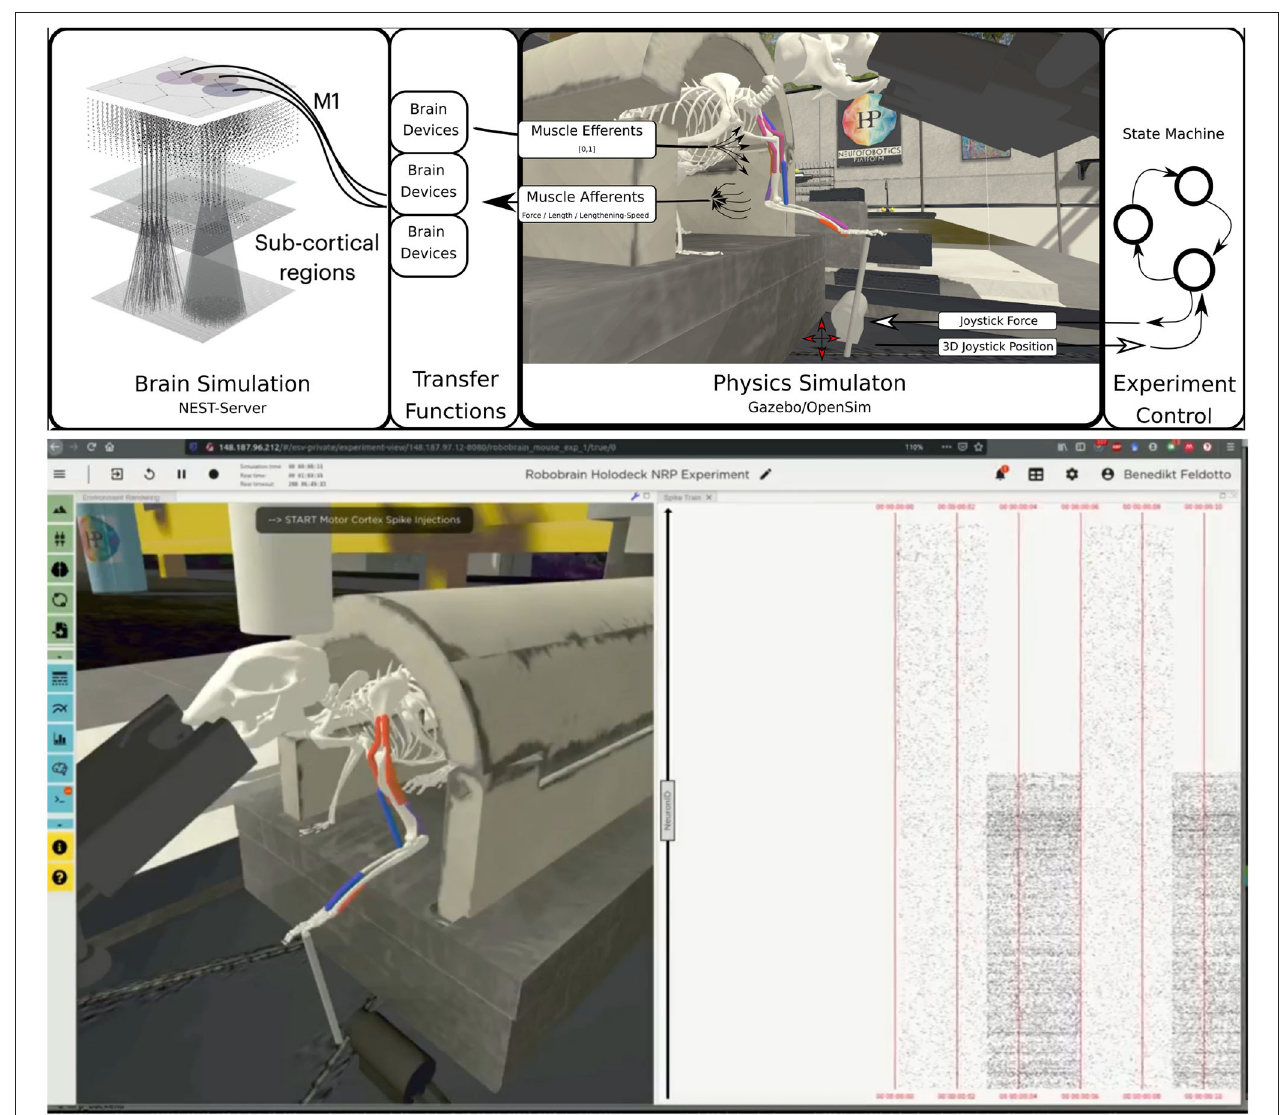
FIGURE 6 | Embodiment of the multi-region rodent brain. (Top) The multi-region brain model is interconnected with the rodent musculoskeletal simulation via Transfer Functions. The readout rate of motor cortex populations actuates the rodent muscles moving the joystick forward. (Bottom) The user can interact with the simulation during runtime via the NRP frontend. Here we show the rendering of the simulated experiment on the left (muscle color coding: red–active, blue–not active) and spike trains of the motor cortex population on the right.